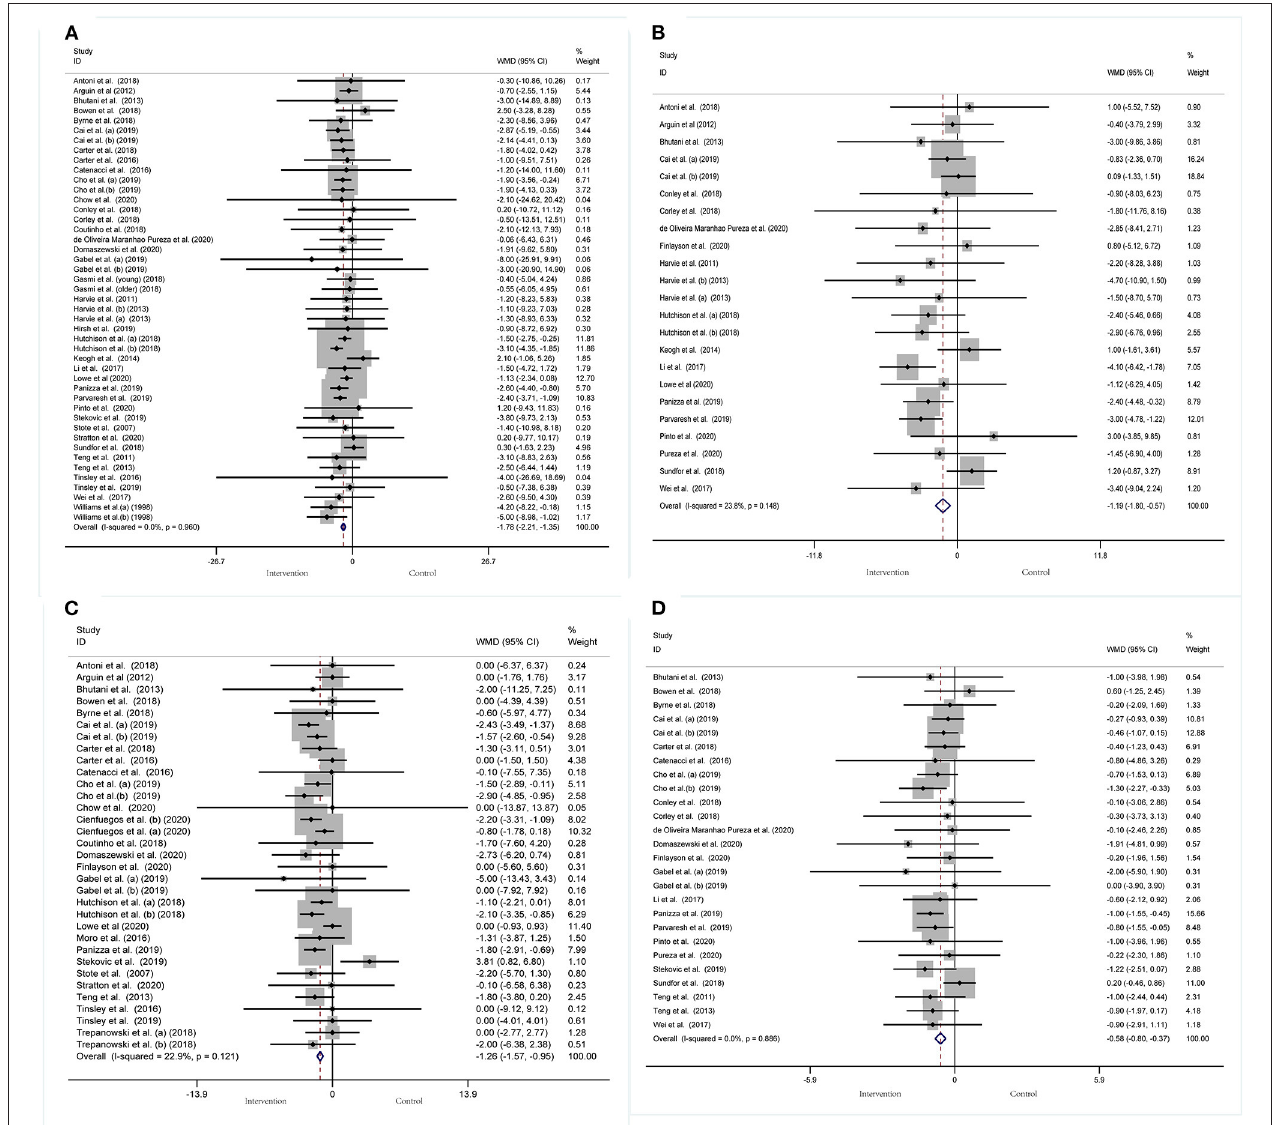
FIGURE 3 | Forest plot of RCTs investigating the effects of intermittent fasting on body composition (A) Weight, (B) WC, (C) FM, (D) BMI.